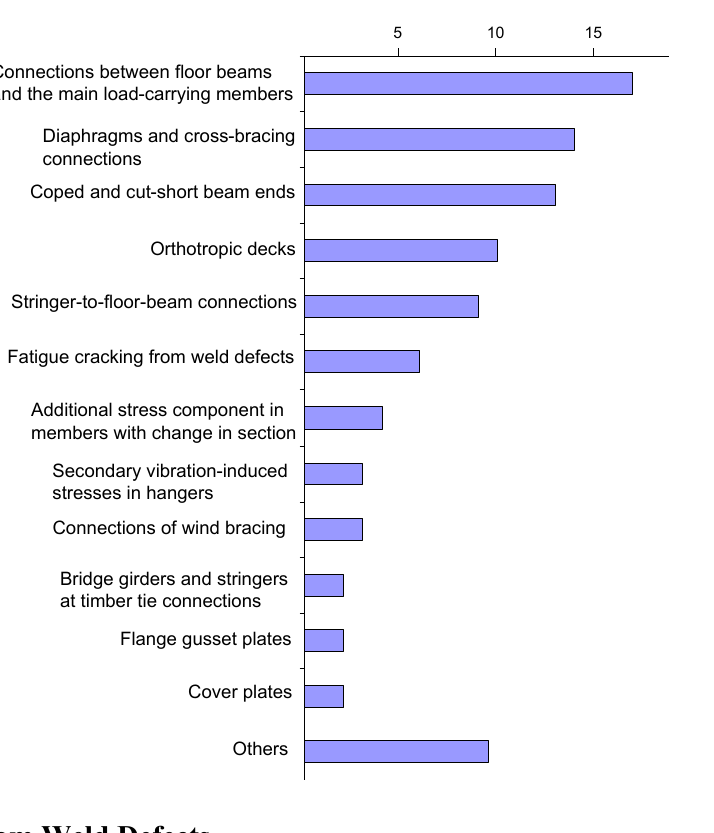
Figure 1. Collected fatigue damage cases listed according to the type of detail in which they were